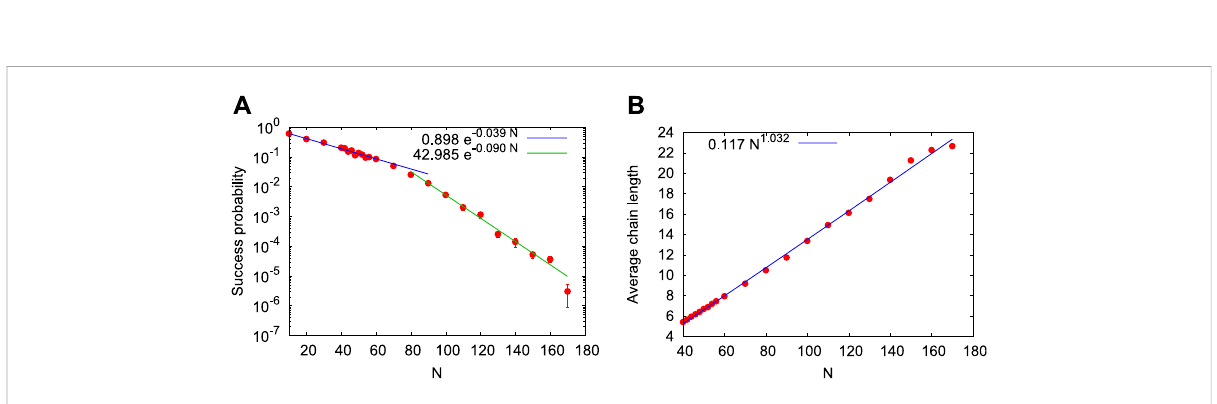
FIGURE 4 (color online) (A) Mean success probability and its variance as a function of the problem size N , obtained by solving all problem instances of the REGclassonaD-Wave Advantage5.1quantumannealer.Solidlinesareleastsquare fi tstodatafor N < 80and N > 80,respectively. (B)